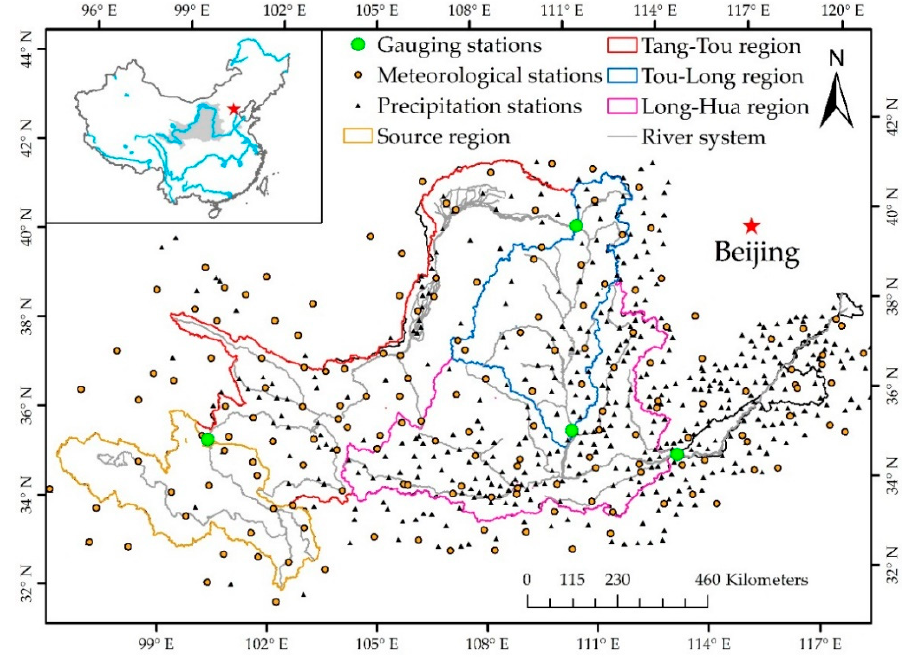
Figure 1. Location and national network of the meteorological and hydrological stations in the YRB.